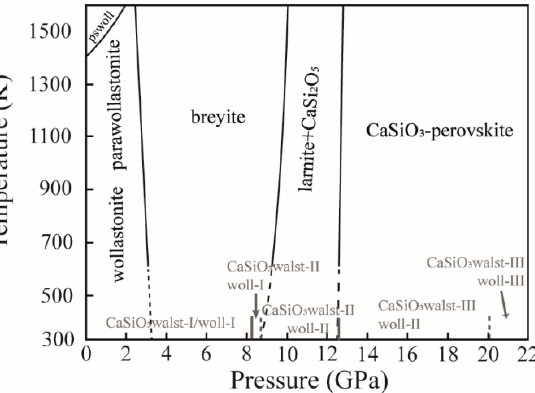
Figure 1. Phase diagram of the system CaSiO 3 . Lines for the wollastonite, breyite fields have been calculated using elastic parameters determined in this paper, the other data have been taken from